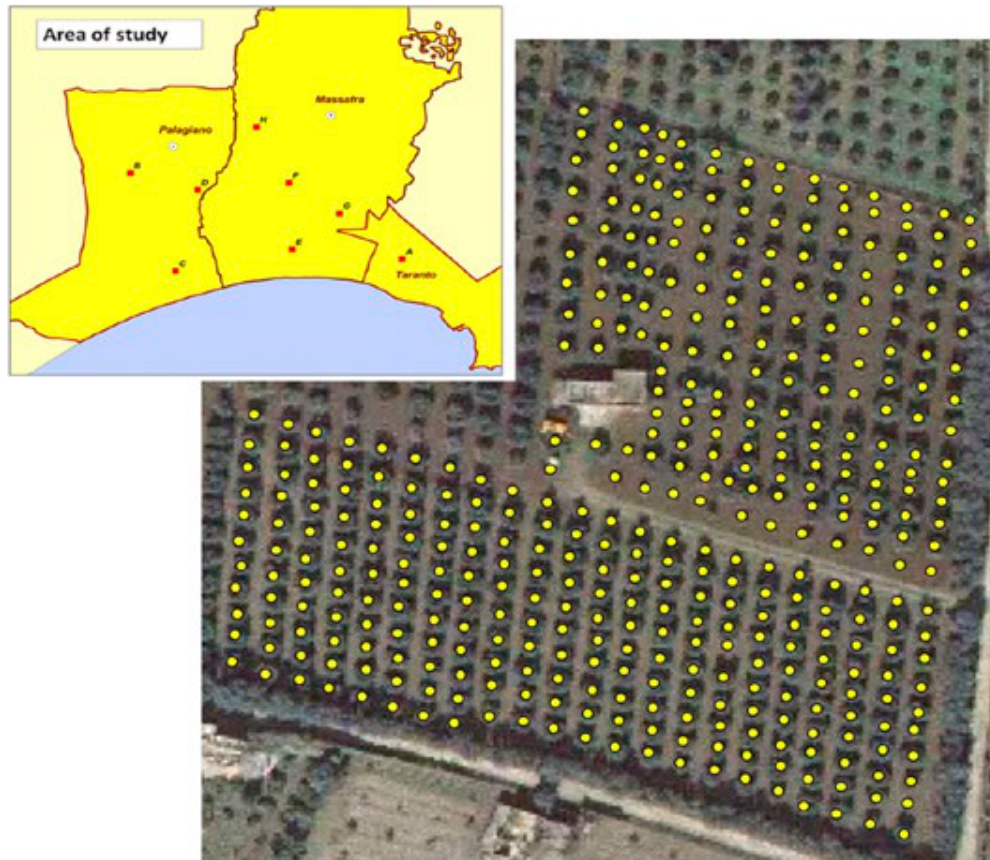
Figure 4. Tree extraction dataset which shows the location and the number of the citrus trees in grove A in Taranto